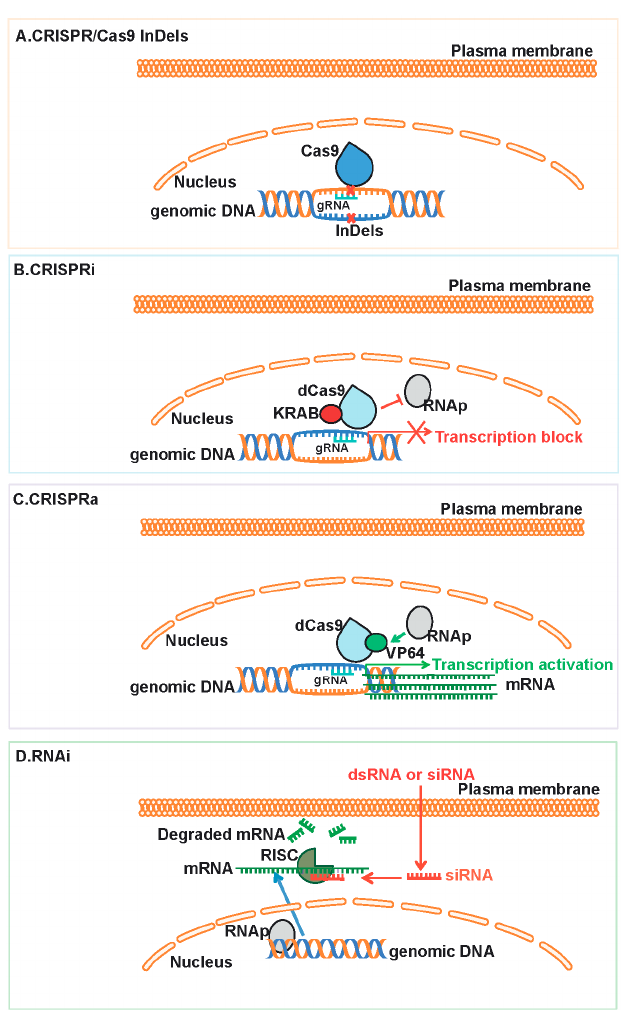
Figure 1. Schematic representation of CRISPR/Cas9 systems and RNAi. The general functioning of CRISPR/Cas9 systems and RNAi are displayed. ( A ) CRISPR/Cas9 induces insertions and deletions (InDel) when targeted to a specific genomic site with the help of appropriate guide RNA (gRNA); ( B ) CRISPR interference (CRISPRi) down-regulates gene transcription; ( C ) CRISPR activation (CRISPRa) up-regulates gene transcription; ( D ) RNA interference (RNAi) down regulates gene transcription by acting post-transcriptionally. dCas, catalytic mutant Cas9; siRNA, small interfering RNA; dsRNA, double stranded RNA; RNAp, RNA polymerase; RISC, RNA induced silencing complex.